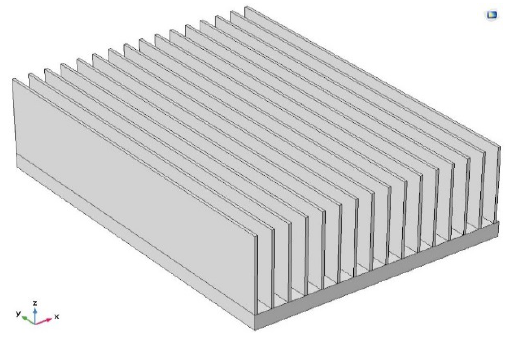
Figure 19. Heatsink for Si model.